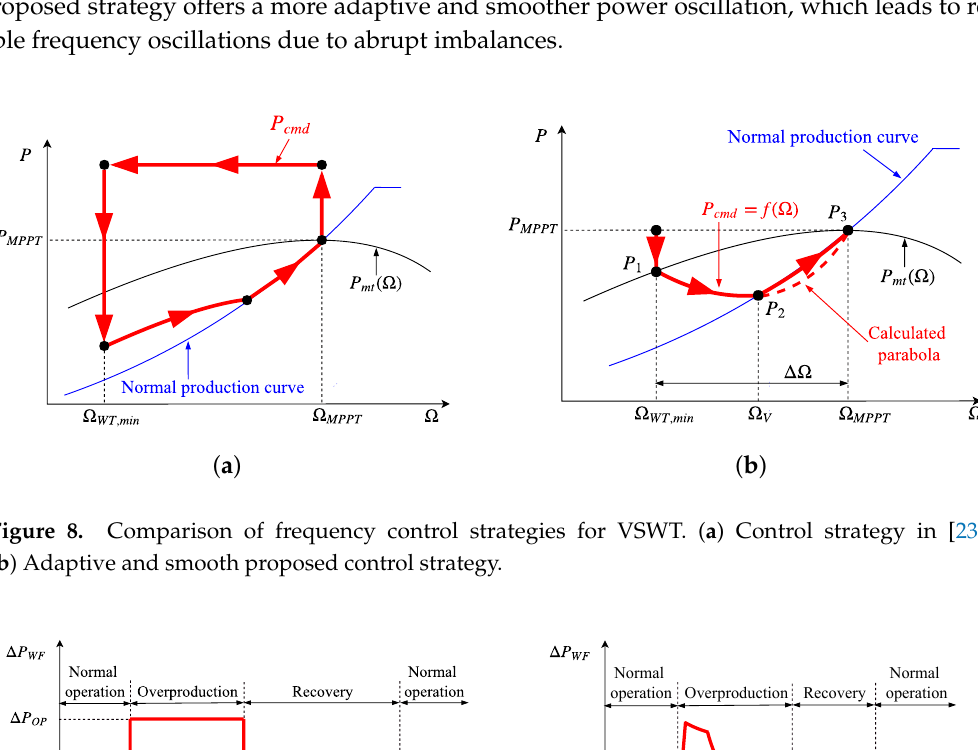
Figure 7. Different proposals for recovery operation mode